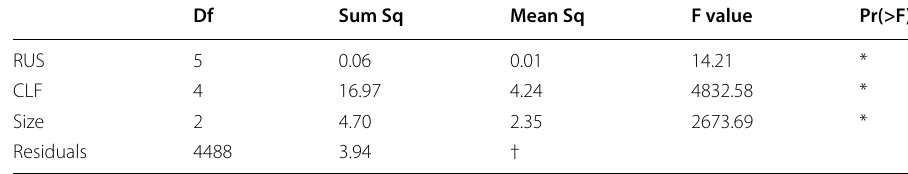
* Indicates value is less than 1 × 10 − 4 , † indicates value is less than 1 × 10 − 2